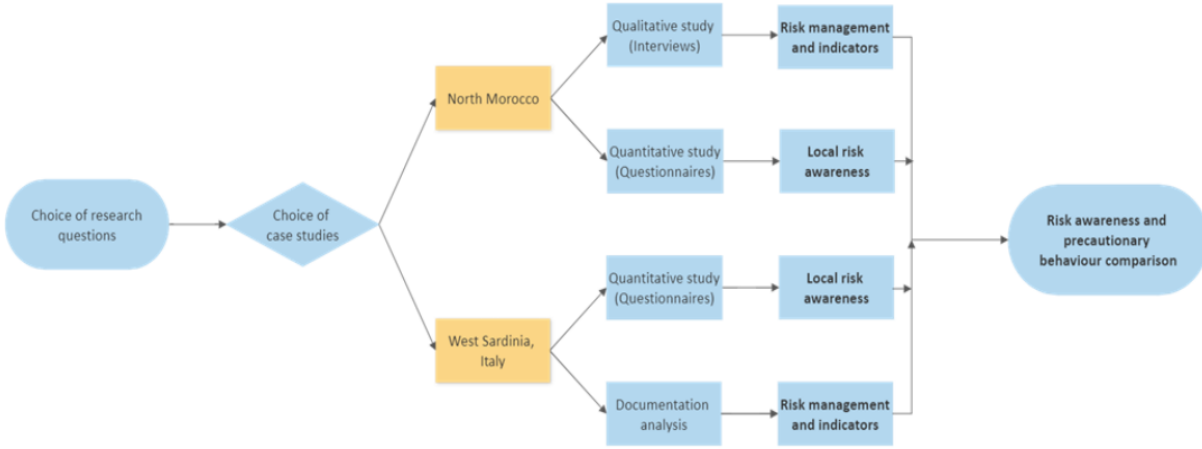
Figure 4. Flow chart (by SmartDraw) explaining the steps of methodology